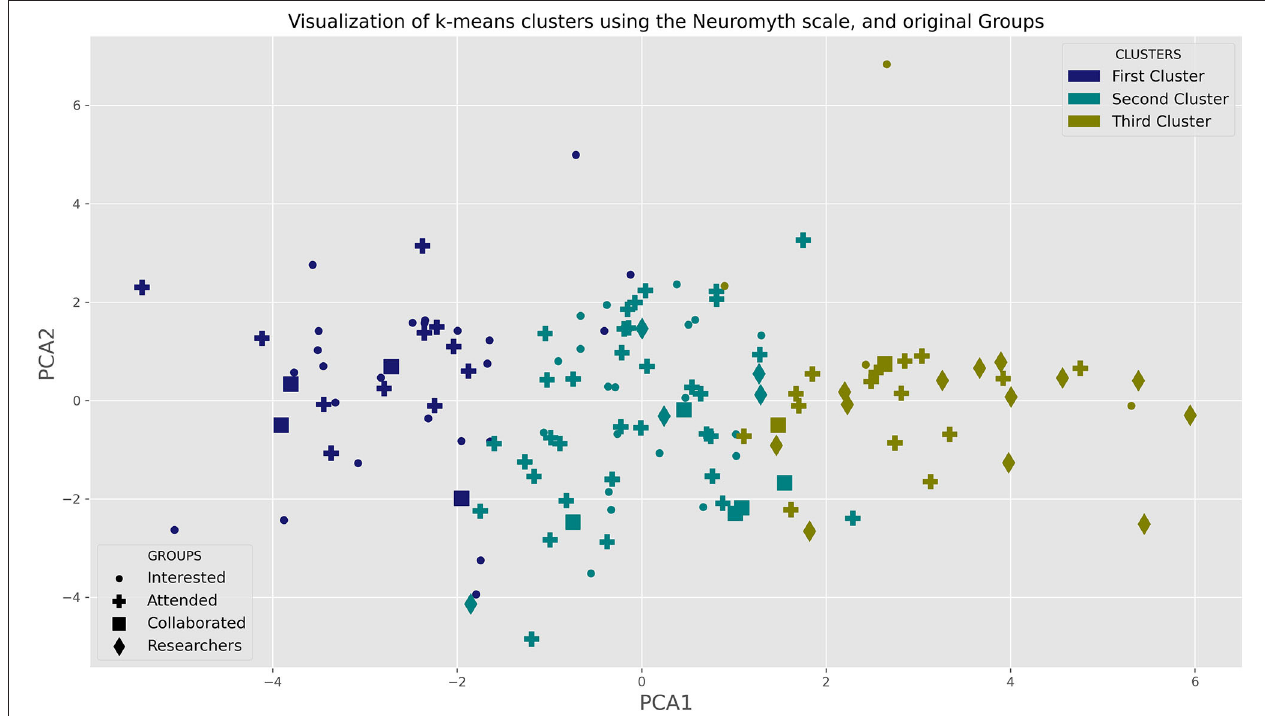
FIGURE 2 | 2D projection and clustering of the responses to the Neuromyth questionnaire. The responses to the Neuromyth Questionnaire were projected to the 2 dimensional space spanned by the principal components of responses. The full set of responses was used to cluster the respondents in three clusters using k-means algorithm. In the graph, the Groups are coded by the markers and the clusters obtained by k-means are coded using colors. Notice that some points seem to be misplaced, but this is due to the fact that the PCA does not capture enough variance (see Supplementary Material for details of the PCA results).